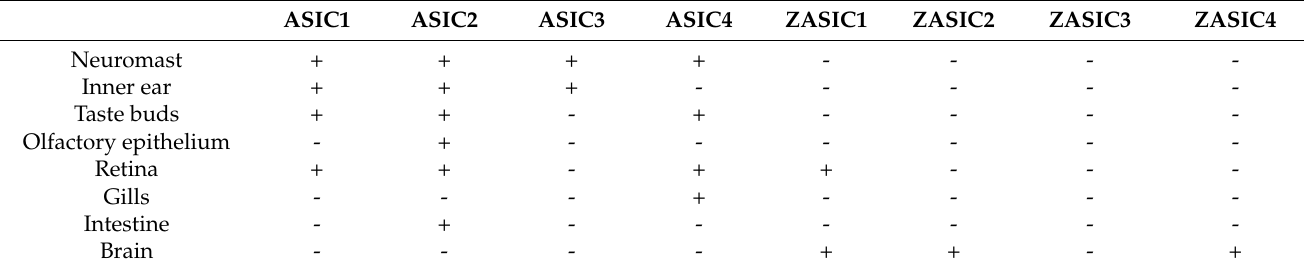
Table 1. Presence and localization of ASICs and ZASICs in adult and larvae zebrafish with techniques of molecular biology and